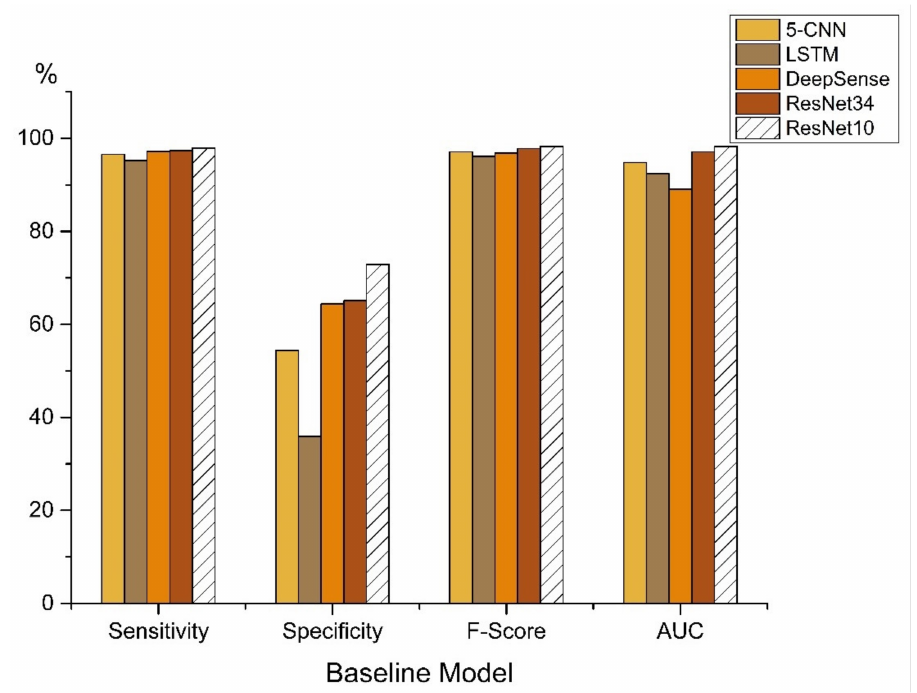
Figure 8. Results of comparison of different deep learning baseline models.